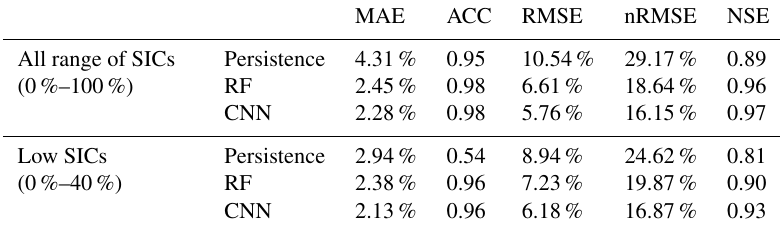
Table 2. Average prediction accuracies among three models on every SIC (0%–100%) and low SICs (0%–40%) during 2000–2017 (mean absolute error, anomaly correlation coefficient, root-mean-square errors, normalized root-mean-square errors, and Nash–Sutcliffe